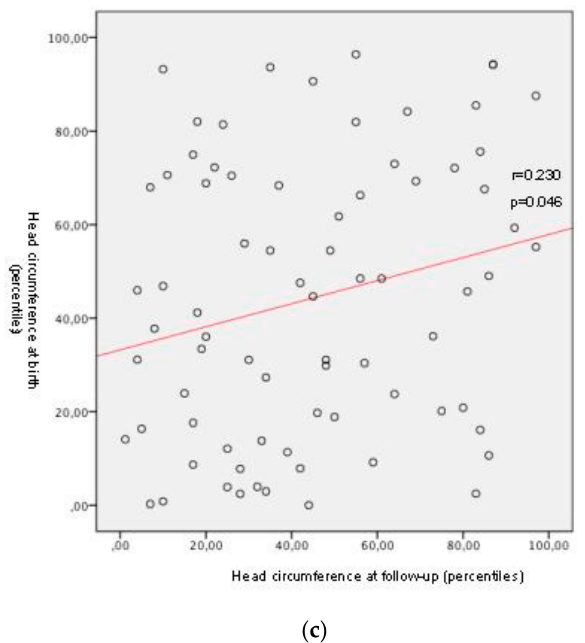
Figure 2. Correlation between percentiles at birth and at follow-up for weight, length or height, head circumference.